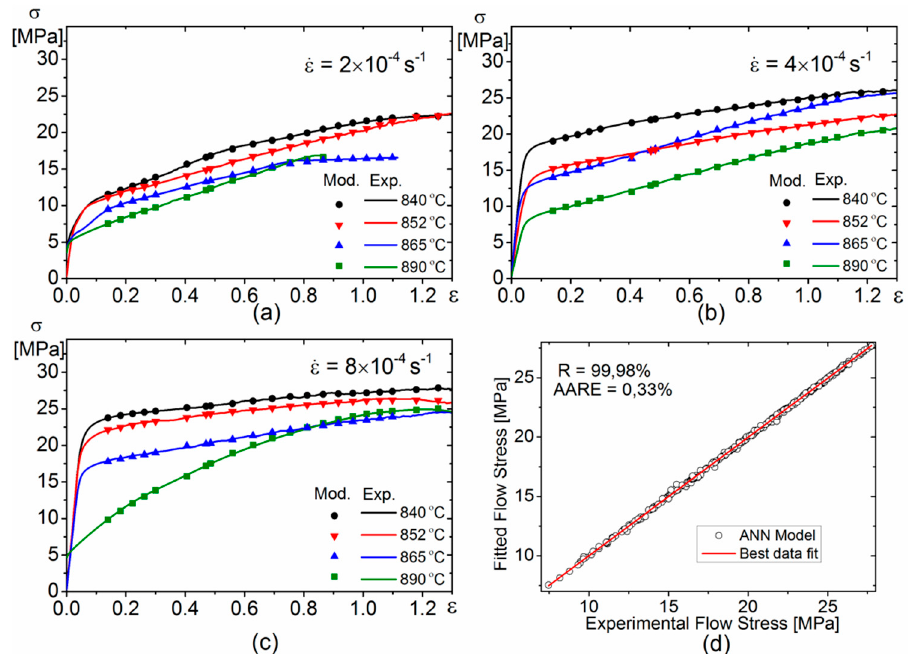
Figure 7 . The true stress–strain curves of the tested alloy at different temperatures and different strain rates with verification of artificial neural network (ANN): ( a ) 2 × 10 − 4 s − 1 ; ( b ) 4 × 10 − 4 s − 1 ; ( c ) 8 × 10 − 4 s − 1 and ( d ) correlation between experimental and predicted flow stress.